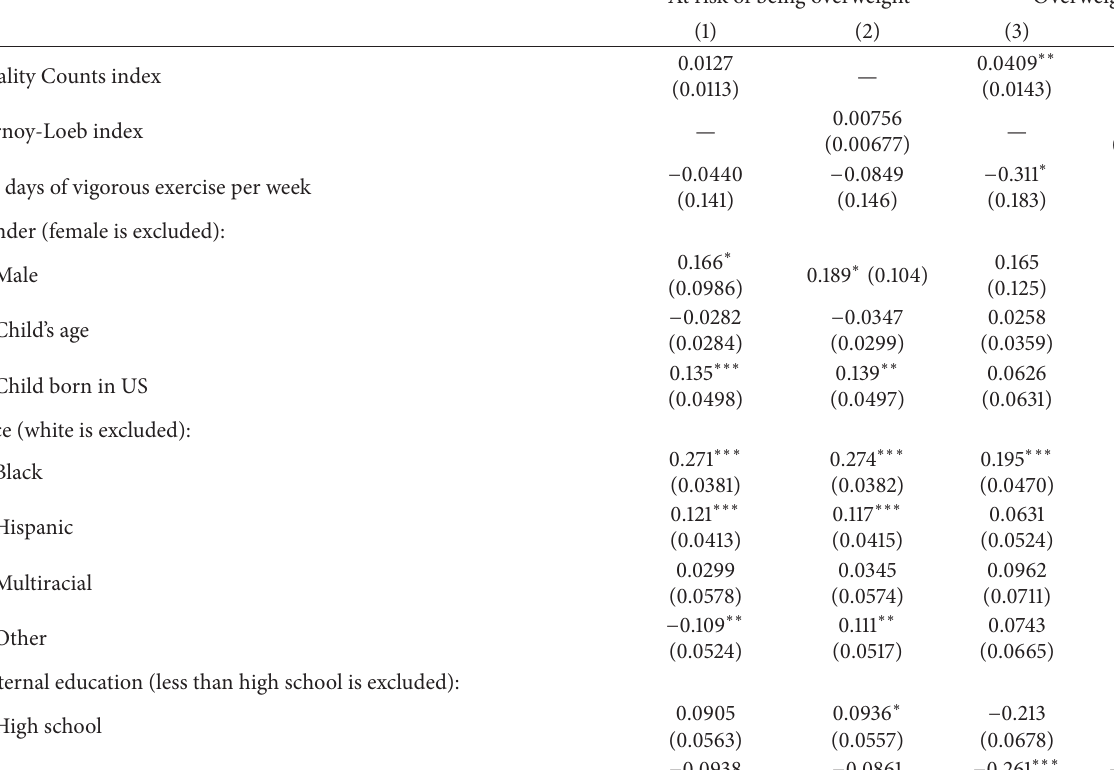
Table 6: Empirical results: effect of accountability pressures on overweight levels among high school children, IV estimates. At risk of being